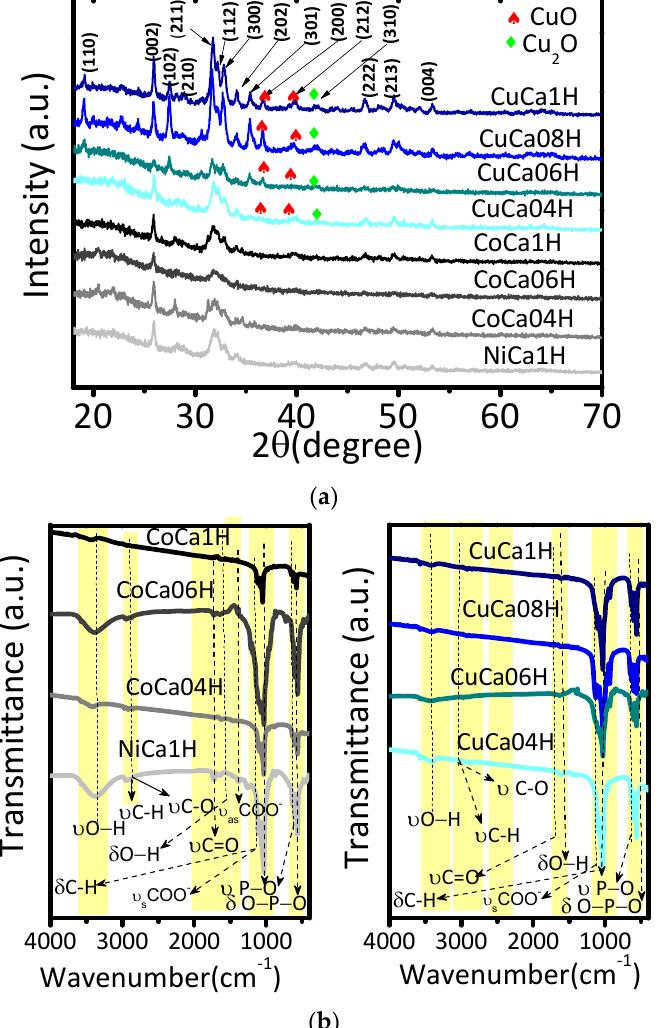
Figure 7. ( a ) XRD patterns and ( b ) FTIR spectra of the spent catalysts. The solids were tested under the following reaction conditions: 75 mg of catalyst, glycerol to acetic acid molar ratio of 0.25, and reaction temperature of 80 °C.